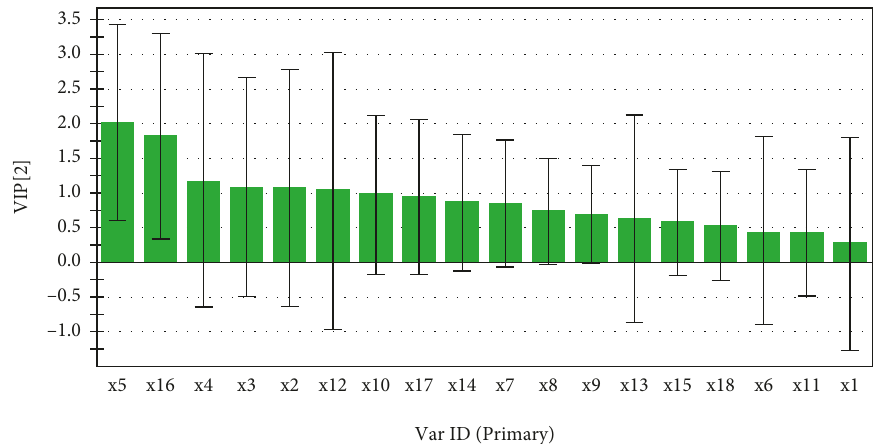
Figure 7: VIP contribution plot of common peak anti-inflammatory